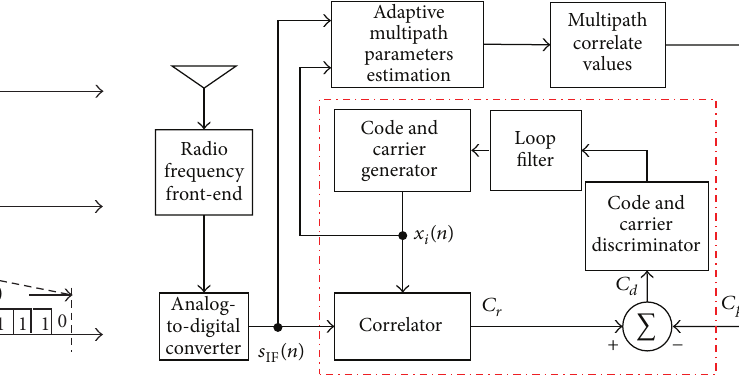
Figure 2: Multipath mitigation